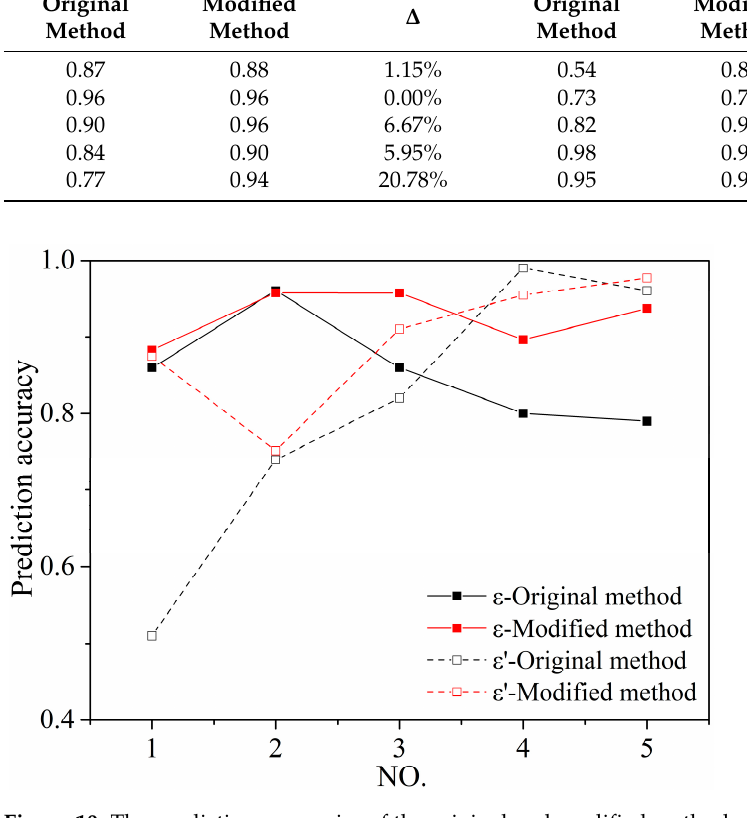
Figure 10. The prediction accuracies of the original and modified methods. The red lines in Figure 10 represent the accuracies of the modified method. Most of the red lines were above the black lines, representing the original method. In the case of ε , the minimum increased to 0.88 in the modified method, while it was 0.77 in the original method. The value of ε ′ calculated with the original method is between 0.54 and 0.98. The modified method improved the minimum to 0.75, which is much higher than before. It should be noticed that ε ′ of serial 4 calculated with the modified method was less than when it was calculated with the original method. However, ε of the modified SCP zone still increased, showing more accuracy than the original one. Moreover, obvious fluctuations could be seen in the original method. That indicated that the original method was more likely to cause a misprediction. The prediction results of the modified method were more stable. The modified method shows more accuracy in guiding the mix design. 4. The Mix Design Method for Multiplexed Powder SCC 4.1. The Definition and Basic Steps Based on the modified paste thresholds, the performance of SCC can be predicted based on paste tests and material property parameters simply. Thus, the mix design pro- cess can be simplified. The flowability of SCC can be forecasted through the mini-SF test of the pastes, thus, the mix design of SCC can be completed without the SCC performance test. Additionally, the performance prediction, the economic cost, and the compressive strength can also be evaluated. As mentioned above, the SCP zone is a set of SCC mix points with good self-compacting performance. The X-axis is Vw/Vp, while the Y-axis is SP%. The evaluation that can be achieved by the SCP zone has three aspects: 1. In the SCP zone, the mix point with lower Vw/Vp uses more powder and has higher compressive strength, but the economic cost increases.